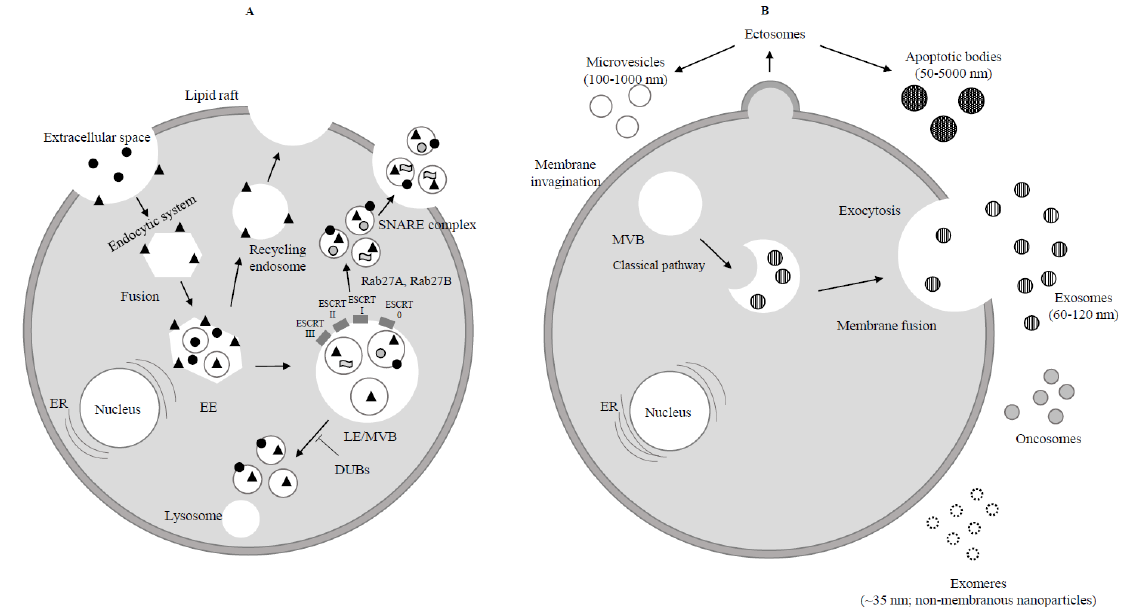
Figure 1. Biogenesis of exosomes. ( A ) Endocytosis begins at the cytoplasmic membrane. Early endosomes (EEs) form by the fusion of uncoated endocytic vesicles. EEs either return to the plasma membrane (recycling endosome) or convert into late endosomes/multivesicular bodies (LEs/MVBs). Protein sorting of ILVs (intraluminal vesicles) occurs through endosomal sorting complexes required for transport (ESCRT) dependent or independent mechanism. ESCRT 0, ESCRT I, ESCRT II, ESCRT III are four components of ESCRT machinery that ubiquitinate the substrates on the part of the inward budding endosomal membrane. ILVs are ready to be degraded by lysosome or rescued by de-ubiquitinating enzymes (DUBs) through Rab GTPases (Rab27A and Rab27B) which allow the MVBs to move to the cell periphery. Finally MVBs through the SNARE complex fuse with the plasma membrane and lead to exocytosis (release of ILVs as exosomes to the extracellular space). Extracellular protein; Receptor; Lipid; RNA. ( B ) Ectosomes derive from the plasma membrane by direct gemmation. Large oncosomes, as microvesicles originate from plasma membrane [8]. Exosomes are derived and secreted through a “classical” pathway. ER = endoplasmic reticulum. Microvesicle; Apoptotic bodies; Exosome; Exomere; Oncosome.